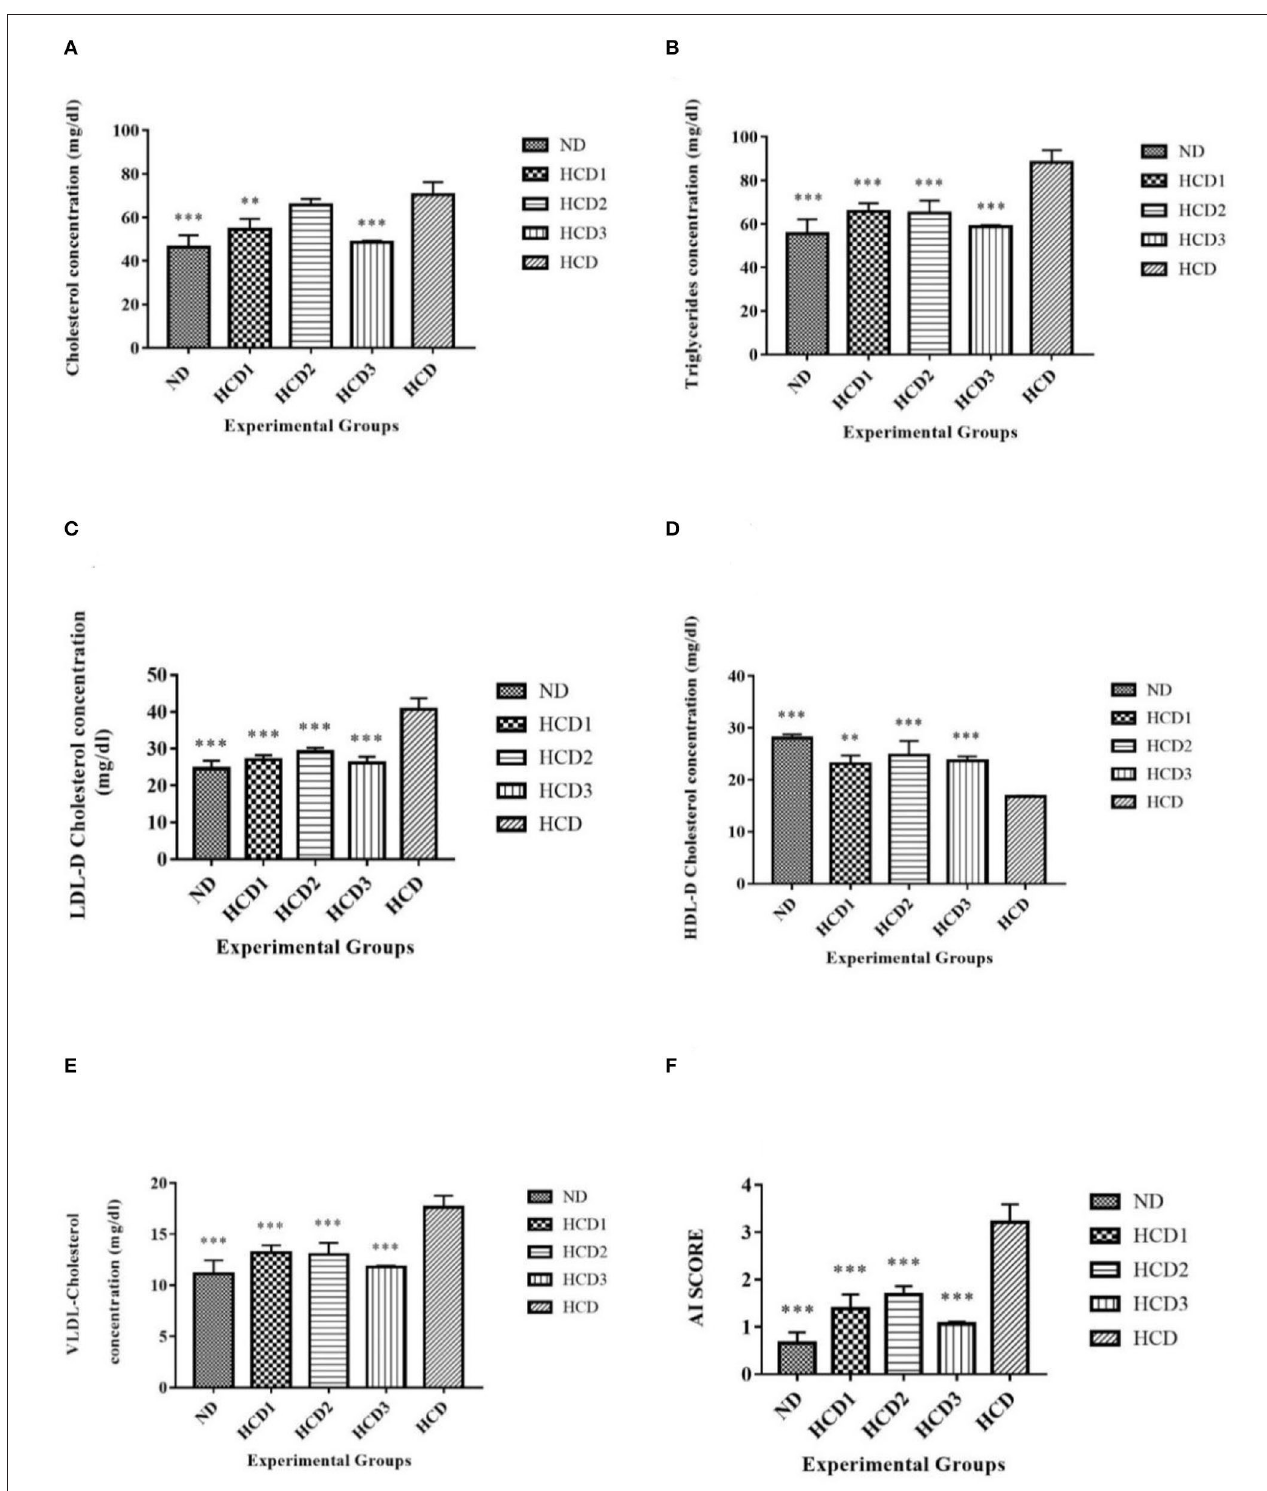
FIGURE 5 | Serum lipid parameters of different experimental groups. Analysis was done by One-way ANOVA followed by Dunnett’s post-hoc test where *** indicates p ≤ 0.001 and ** indicates p ≤ 0.01. All data represented as mean ± SD of 6 animals. (A) Cholesterol (B) Triglycerides. (C) LDL-D cholesterol. (D) HDL-D cholesterol. (E) VLDL-D cholesterol. (F) Atherogenic Index